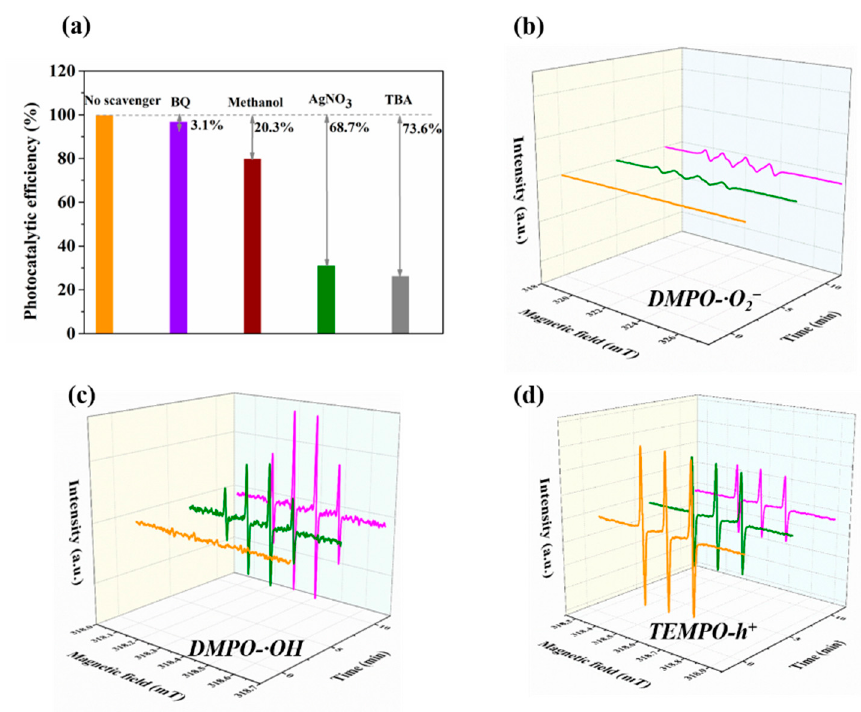
Figure 10. ( a ) E ff ects on bisphenol A degradation with di ff erent hole scavengers; ( b – d ) ESR spectra of Figure 10. ( a ) Effects on bisphenol A degradation with different hole scavengers; ( b – d ) ESR spectra various radical of various radical adducts.